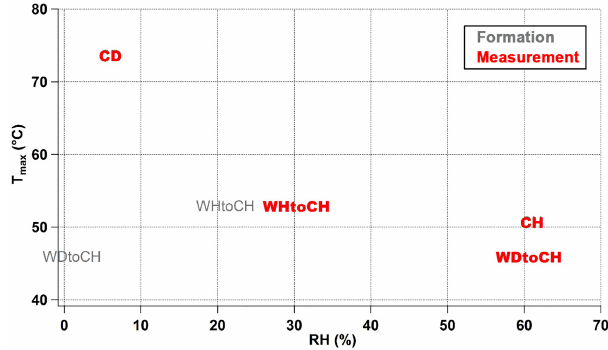
Figure 8. Relationship of RH formation (gray), RH measurement (red), and T max of all CHOI monomer compounds for four experiments at t